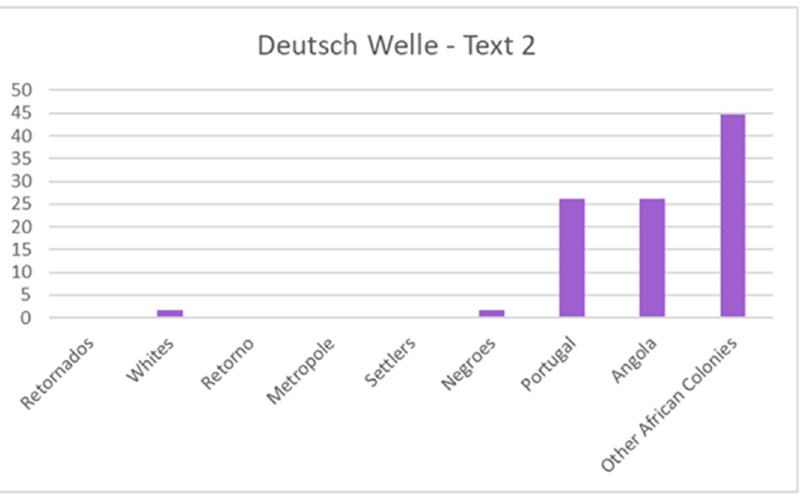
Figure 10. Most frequent words in the text “Cronologia 1961–1969: Início da Guerra Colonial e viragem no destino das colónias”. Source: Deutsche Welle (2013) [24]. viragem no destino das col ó nias”. Source: Deutsche Welle (2013)